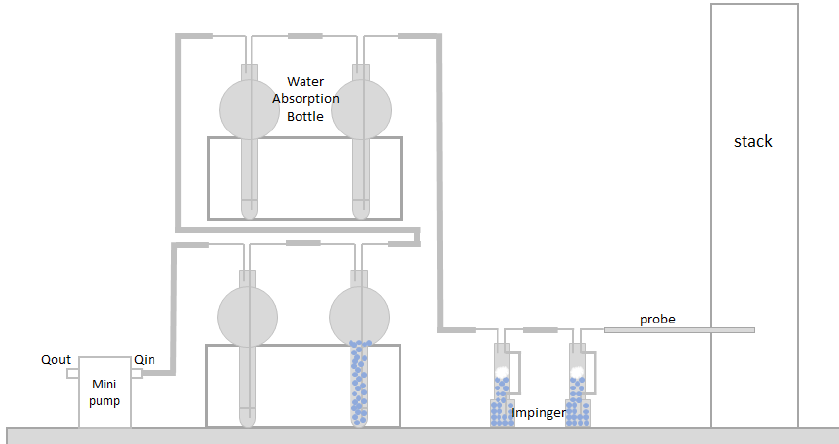
Figure 1. Schematic of the field setup for ammonia sampling at power plant.